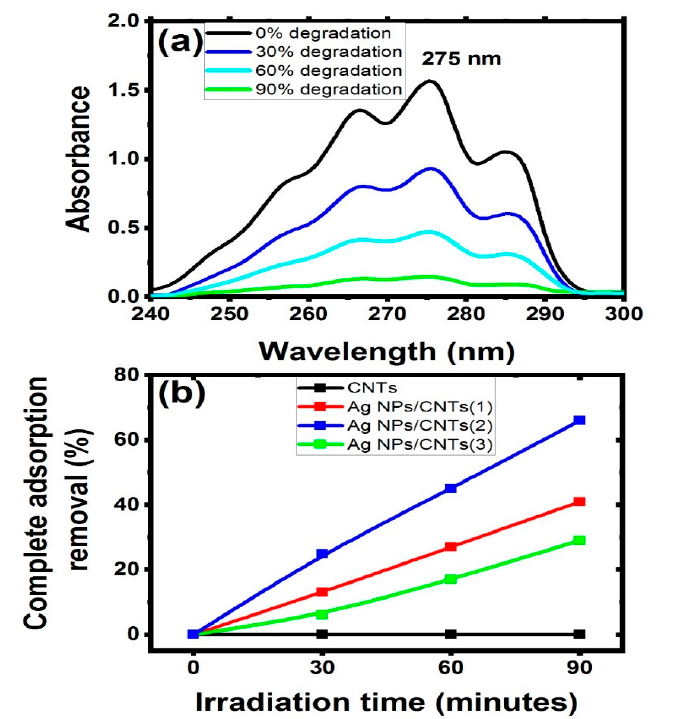
Figure 7. ( a ) Photocatalytic degradation of naphthalene by using Ag NPs/CNT(2), and ( b ) the rela- tionship between irradiation time against the complete adsorption removal percentage of the used CNTs and their decoration by Ag NPs with different concentrations based on tuning laser ablation time. ablation time.